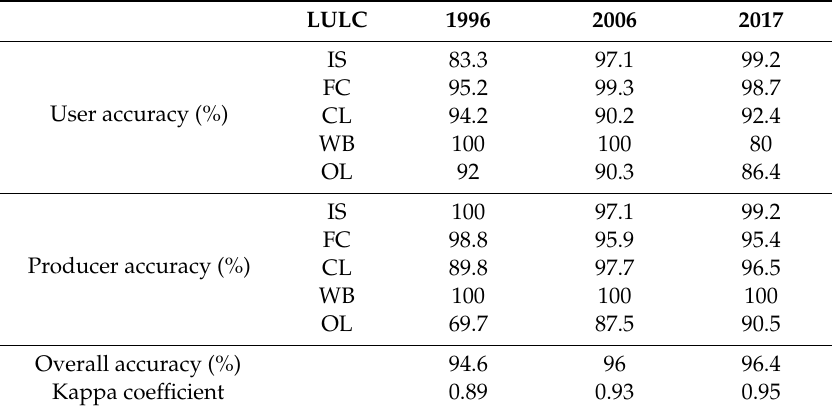
Table 4. Accuracy assessment of LULC